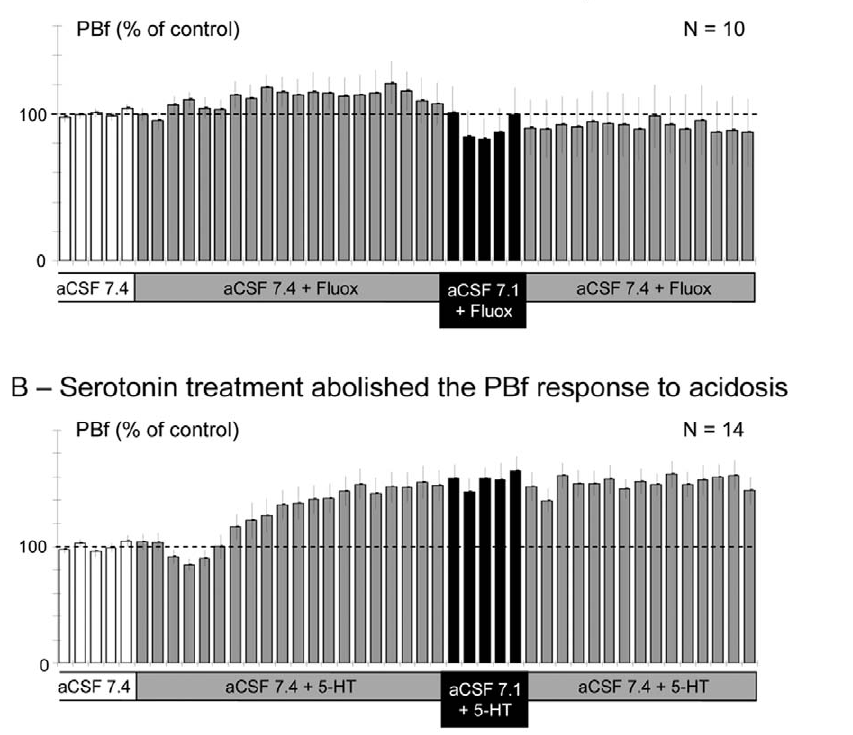
Figure 2. Fluoxetine and serotonin pre-treatments abolish the increase of phrenic burst frequency induced by acidosis. A - Columns of the histogram show the mean (and SEM) PBf (expressed as % of the control PBf) measured every min (one column =1 min) in 10 preparations when the control aCSF(7.4) (white columns) superfusing the preparations was first replaced by aCSF(7.4) containing fluoxetine (10–25 m M) for 20 min to block the serotonin transporter SERT (grey columns) and thereafter by aCSF(7.1) containing the same amount of fluoxetine for 5 min (black columns). Note that pre-treatment with fluoxetine did not significantly increase the PBf but abolished the PBf increase under acidosis. B - PBf changes (expressed as % of control) every min (one column) but for 14 preparations superfused with control aCSF(7.4) (white columns), aCSF(7.4) containing serotonin, 5-HT (1–5 m M) for 20 min (grey columns) and thereafter aCSF(7.1) containing the same amount of 5-HT for 5 min (black columns). Note that pre-treatment with 5-HT significantly increased the PBf by about 50% and, similarly to fluoxetine treatment, abolished the PBf increase under acidosis.